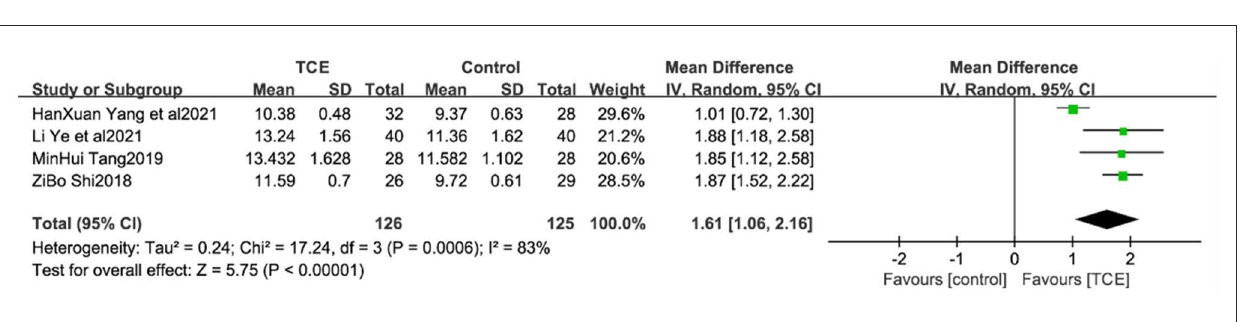
FIGURE7 The effect of Traditional Chinese exercises on patients’